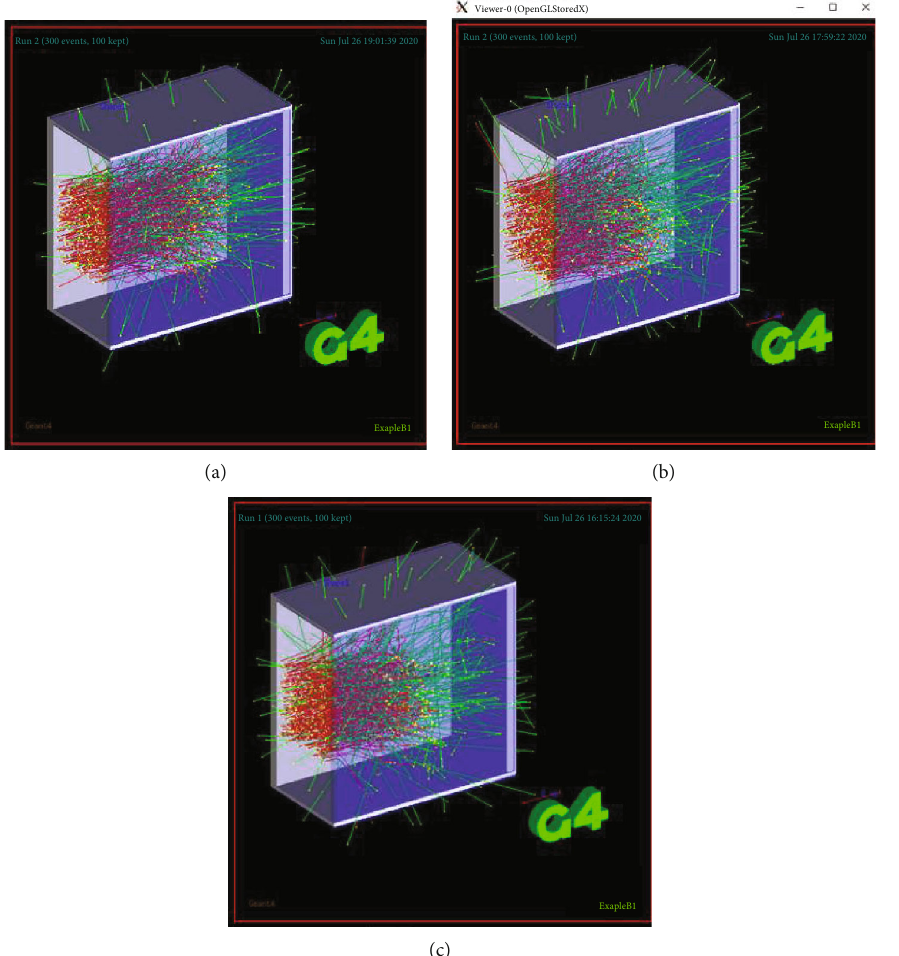
Figure 5: Event display of beam-path length of 12MeV electron beam in acrylic container fi lled with di ff erent densities of solution: (a) 0.78g/cm 3 (alcohol), (b) 0.93g/cm 3 (2-ethoxyethanol), and (c) 1g/cm 3 (pure water). Red color represents electron tracks and green color indicates gamma rays.